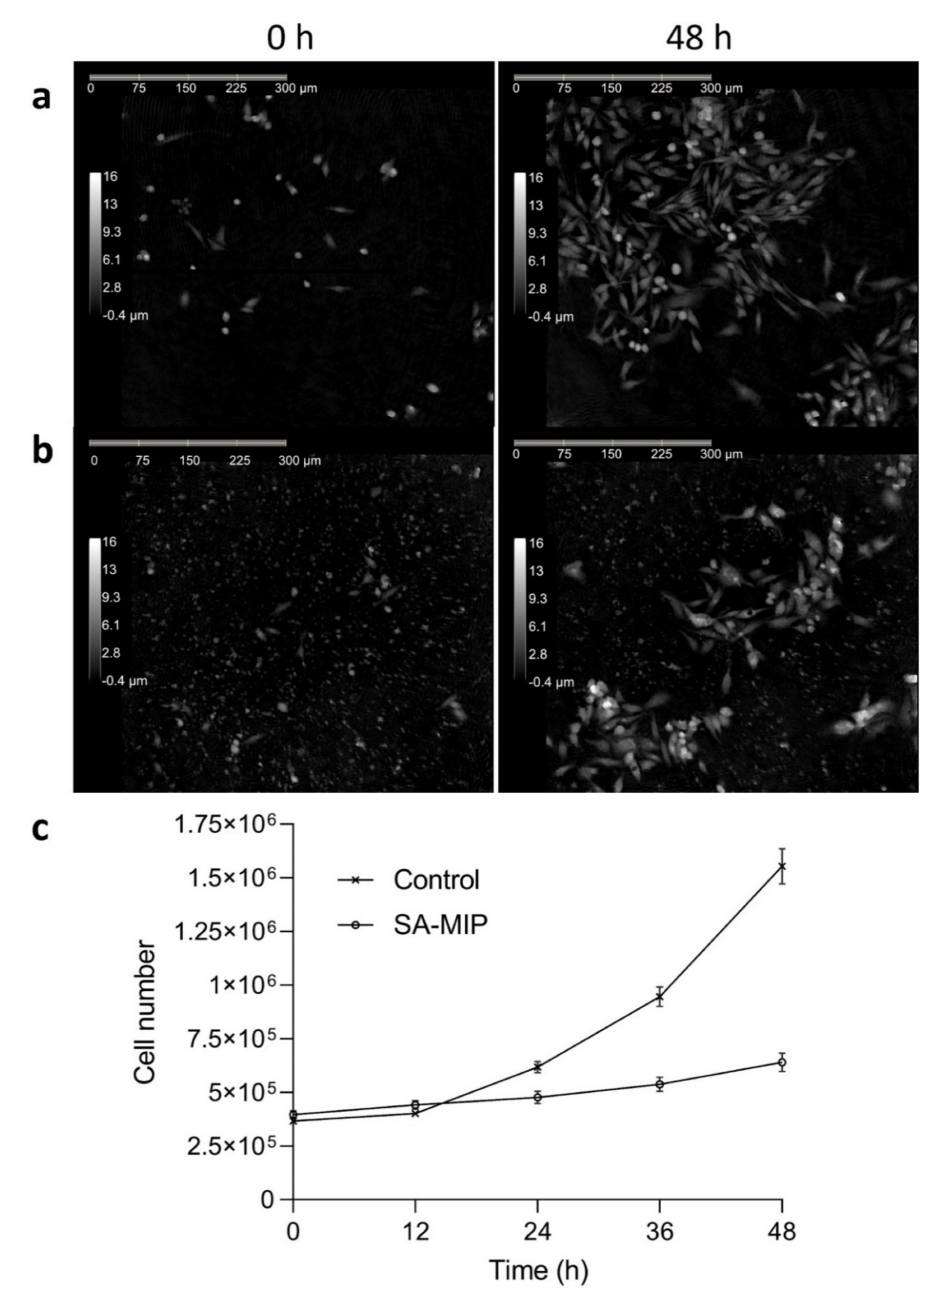
Figure 6. DHC images in 2D and cell proliferation. Representative images from DHC time-lapse at time-point 0 h and 48 h of RAW 264.7 cells incubated with medium ( a ) or 40 µ g/mL SA-MIPs ( b ). The SA-MIPs were added immediately before the start of the time-lapse and are seen as small dots surrounding the cells. The horizontal scale bars at the top in the images represent 300 µ m and the vertical scale bars to the left represent the optical thickness − 0.4 to 16 µ m. Average number of cells visible in time-lapse frames over 48 h ( c ) of three independent experiments with ± SD. RAW 264.7 cells were seeded with medium for 24 h. Time-lapse imaging was initiated when 40 µ g/mL SA-MIPs was added 24 h after cell seeding. This corresponds to time 0 in ( c